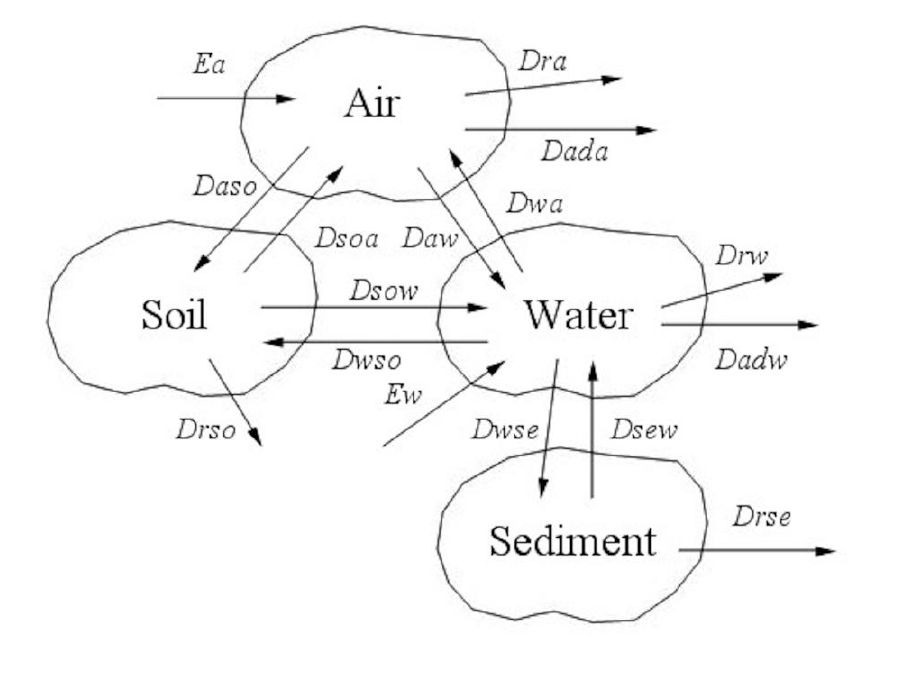
Figure 2. Chemical transport processes in the environment.